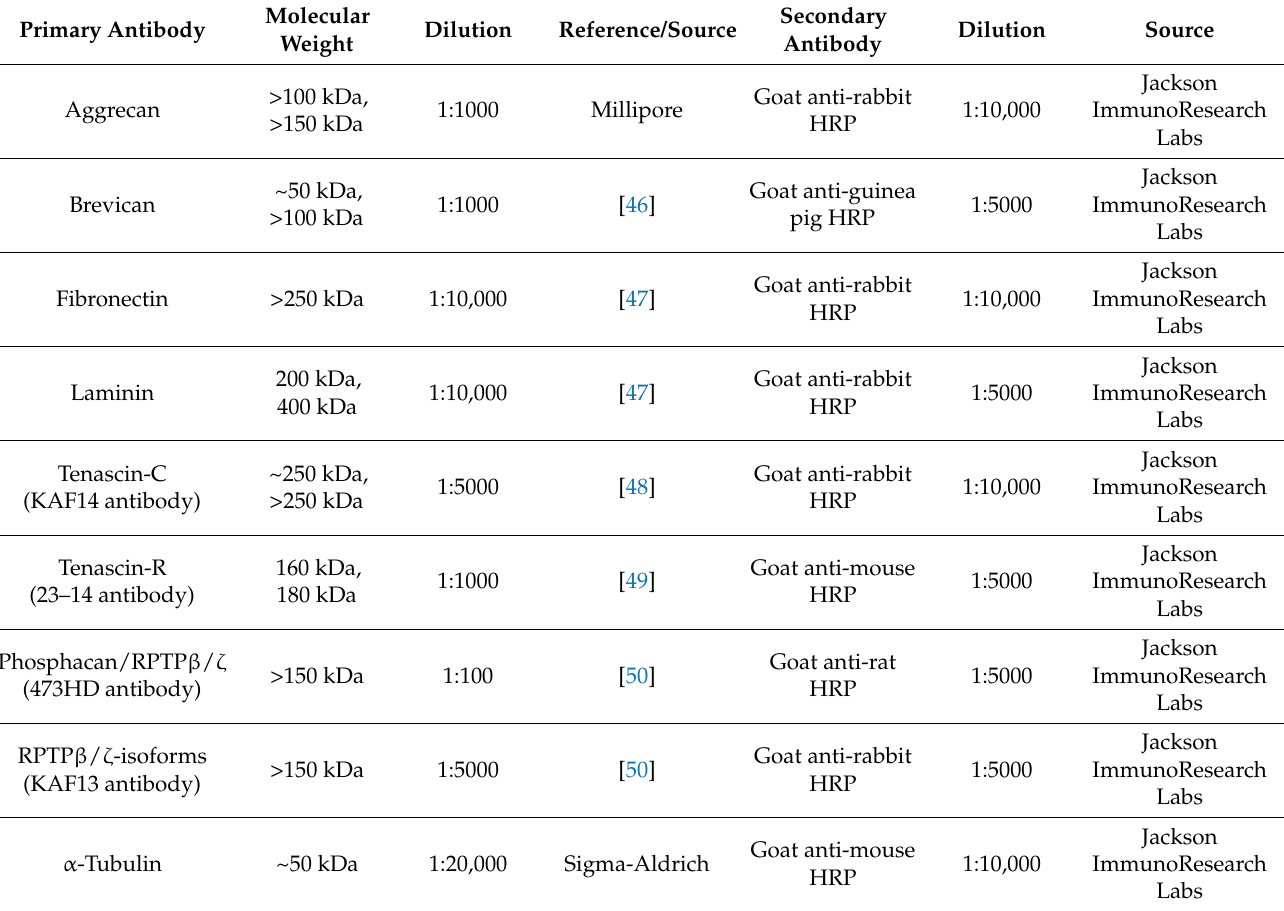
Table 4. Primary and secondary antibodies for Western